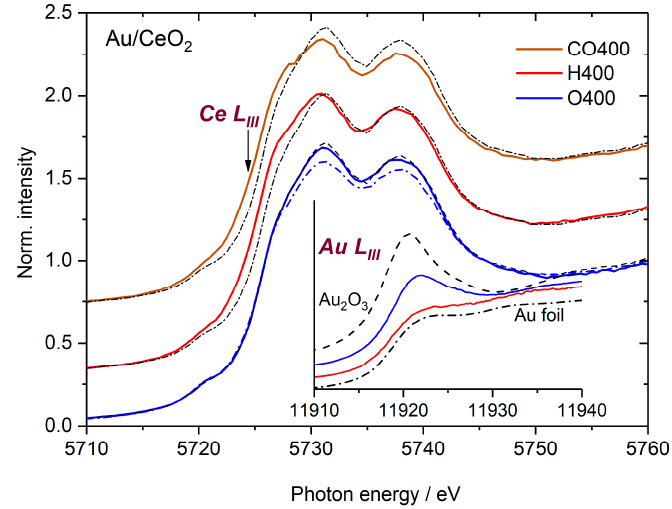
Figure 3. Spectra recorded on the Au/CeO 2 catalyst at the Ce L III edge after different pre-treatment procedures: H400 (red solid line), O400 (blue solid line), and CO400 (orange solid line). The black dash-dotted line denotes the Ce(IV) reference. The inset (lower right part) displays the respective spectra recorded in transmission at the Au L III edge, together with a spectra of the Au references (dashed line: Au 2 O 3 , dashed dotted line: Au foil).